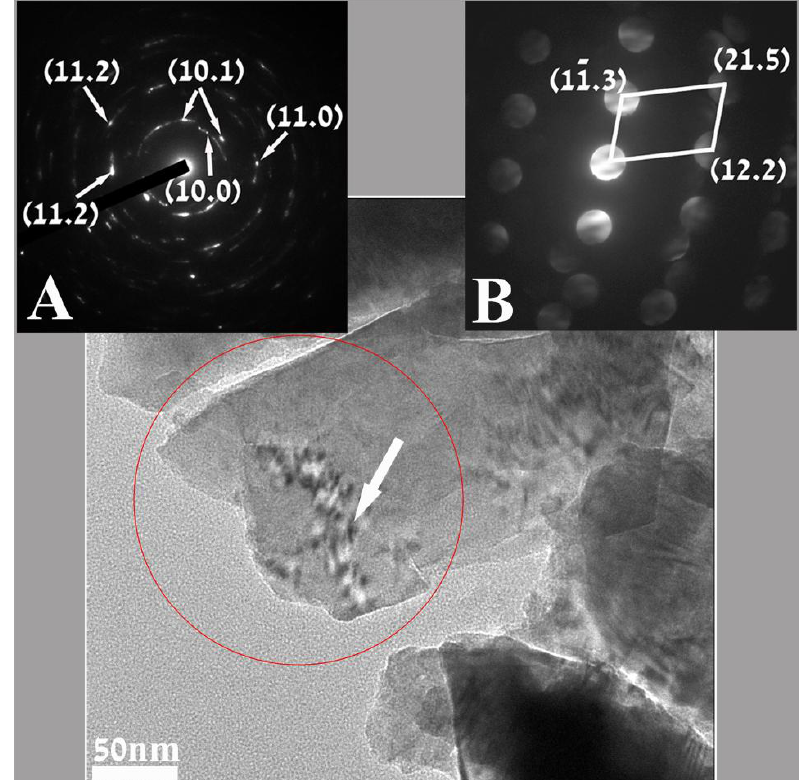
Figure 2. Transmission electron microscopy (TEM) image of representative nanoparticles of milled “Cauliflower-like” ZnO microparticles. Inset ( A ) is the selected area electron diffraction (SAED) taken from a 200 nm area marked by the red cycle, displaying reflections matching the ring diffraction pattern for the hexagonal ZnO. The nano beam electron diffraction (NBD), inset ( B ) recorded from a 4nm area, marked by the arrow, points also to the hexagonal